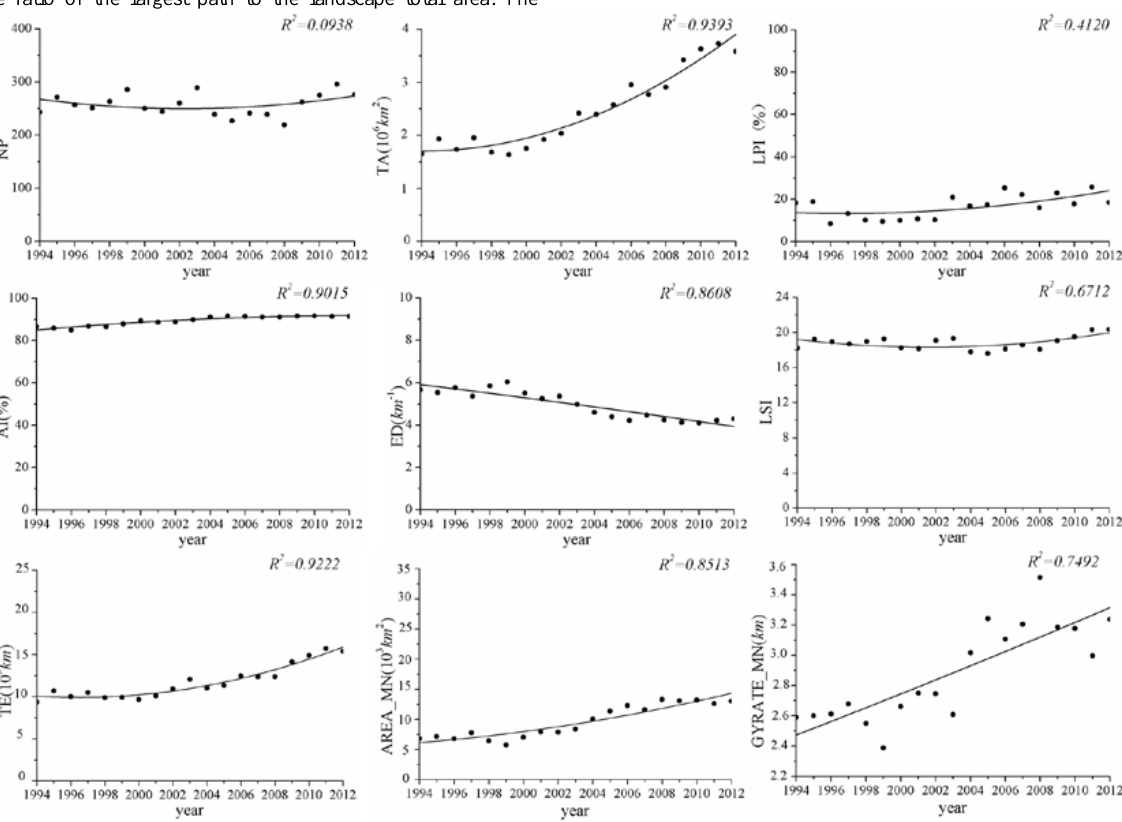
Figure 5. Trend chart of nine landscape metrics of Shandong from 1994 to